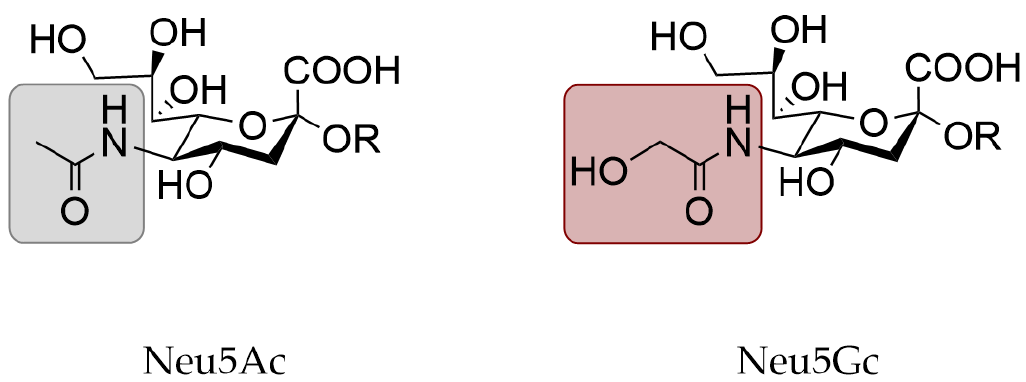
Figure 1. Structure of N-acetylneuraminic acid (Neu5Ac) and N-glycolylneuraminic acid (Neu5Gc).